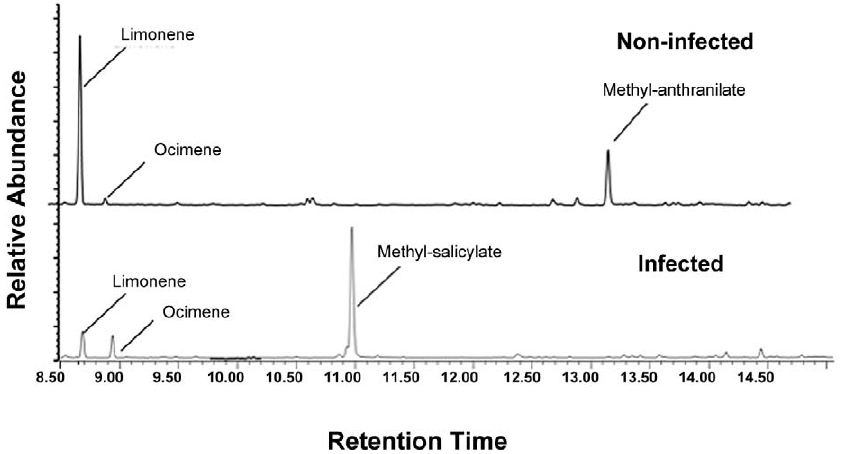
Figure 5. Chromatograms displaying volatile differences between Las-infected and non-infected plants. Release of methyl salicylate was significantly greater from plants infected with Las, while release of D-limonene and methyl anthranilate was significantly greater from non- infected plants.